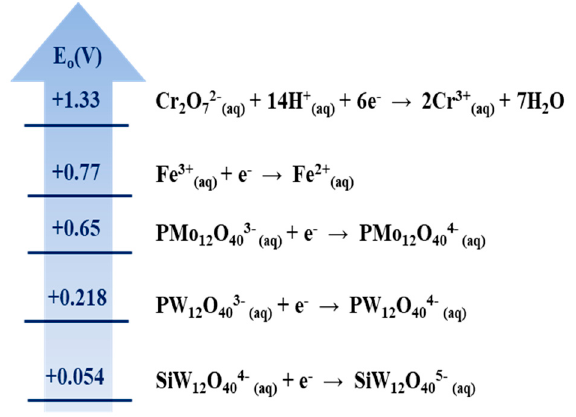
Figure 1. Reduction potential of various compounds used in this study.